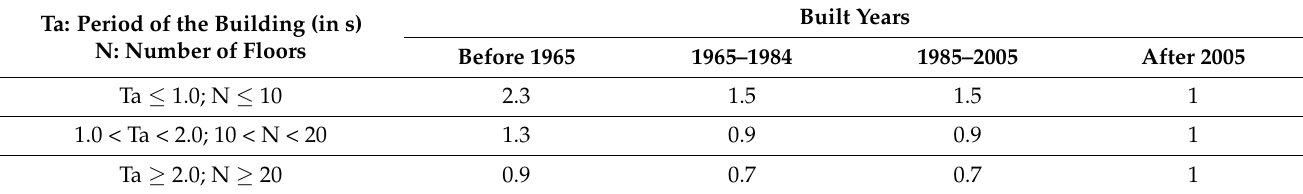
Table 2. Matrix used to determine criterion A (adapted from NRC1992, NBCC2005, and FEMA-154). Ta: Period of the Building (in s) N: Number of Floors